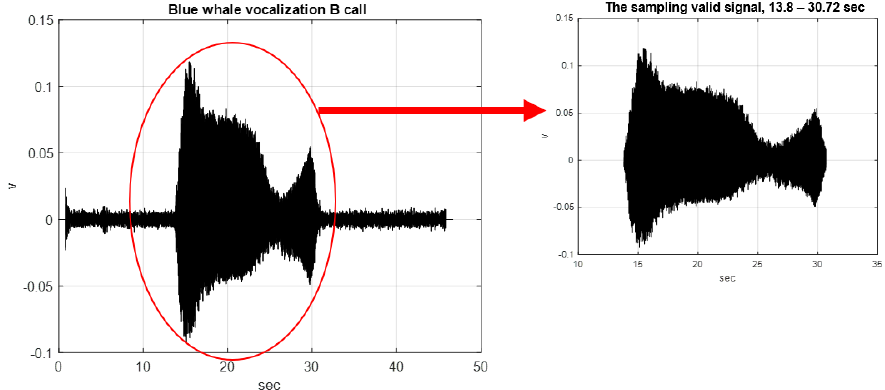
Figure 2. Blue whale B call vocalization with noise (the time length is 46.65 s, sampling frequency is 7350 Hz), and sampling valid signal (the time length is 16.92 s).